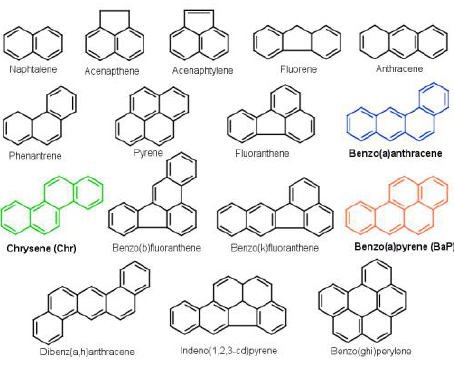
Figure 1. Chemical structure of the “parent PAH” molecules. The colored molecules (Benzo(a)anthracene, Chrysene and Benzo(a)pyrene) are involved in the studied reaction mechanism.